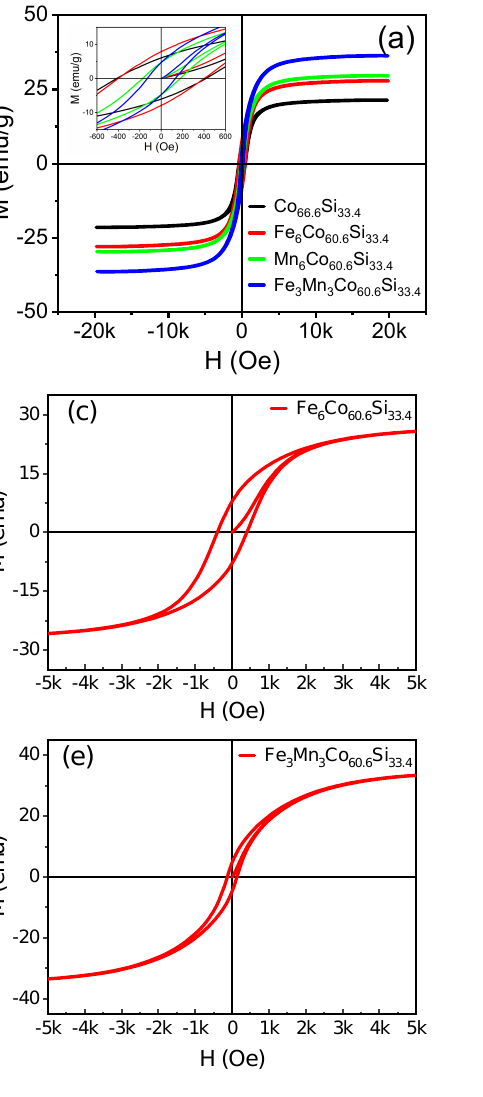
Figure 4. ( a – e ) Hysteresis loops of the as-prepared Co 66.6 Si 33.4 , Co 60.6 X 6 Si 33.4 , (X = Fe, Mn), Co 60.6 Fe 3 Mn 3 Si 33.4 samples sintered at 950 °C. They obtained a saturation magnetisation of 18 KA/M, indicating that the magnetic properties are better than those obtained in our study. However, they performed they found powder heating at 1000 °C for 50 h, which requires complex instrumentation as Co 2 Si is easily oxidised at high temperatures. Van der Walls-Zeeman [16] obtained Co 2 Si by ball milling and sintering. They milled Co 2 Si for 120, 260, and 629 h, then sintered it at 900 K. The diffraction peak matched the diffraction pattern of Co 2 Si for the sample ball-milled for 629 h. However, the machine was continuously operated for hundreds of hours, resulting in damage to the mechanical bearing. Therefore, our method is more